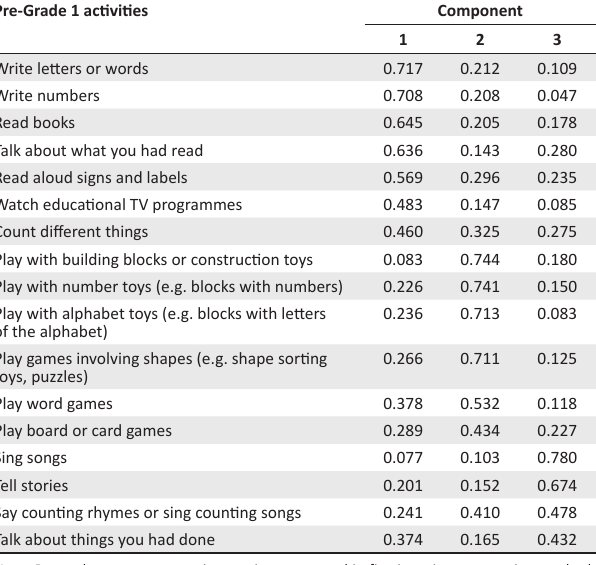
TABLE 2: Components extracted through principal component analysis.